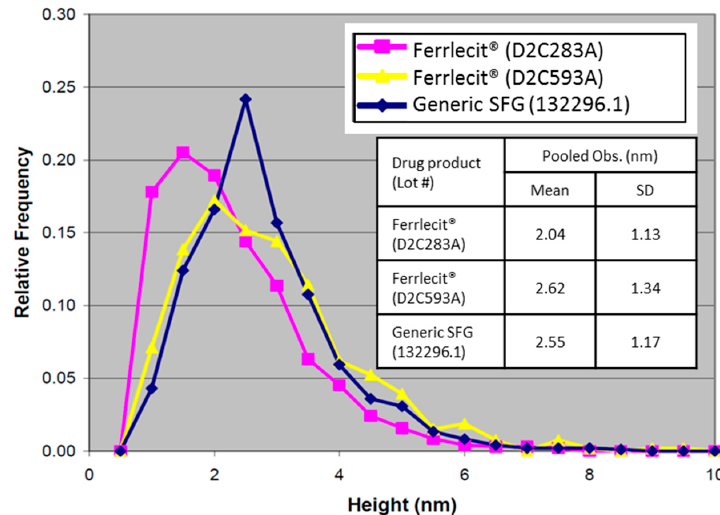
Figure 4. Histograms of the AFM-depth intensities as a function of particle height. Inset: pooled average of particle heights with the standard deviation for Ferrlecit D2C283A ( n = 950), Ferrlecit D2C593A ( n = 534), and generic SFG 132296.1 ( n = 976).